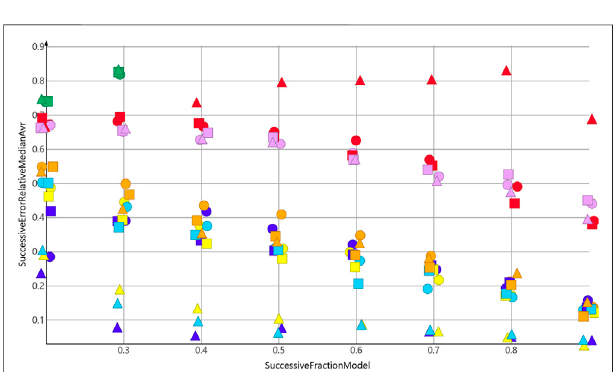
FIGURE 4 | sp3-atoms, random shuf fl ing.